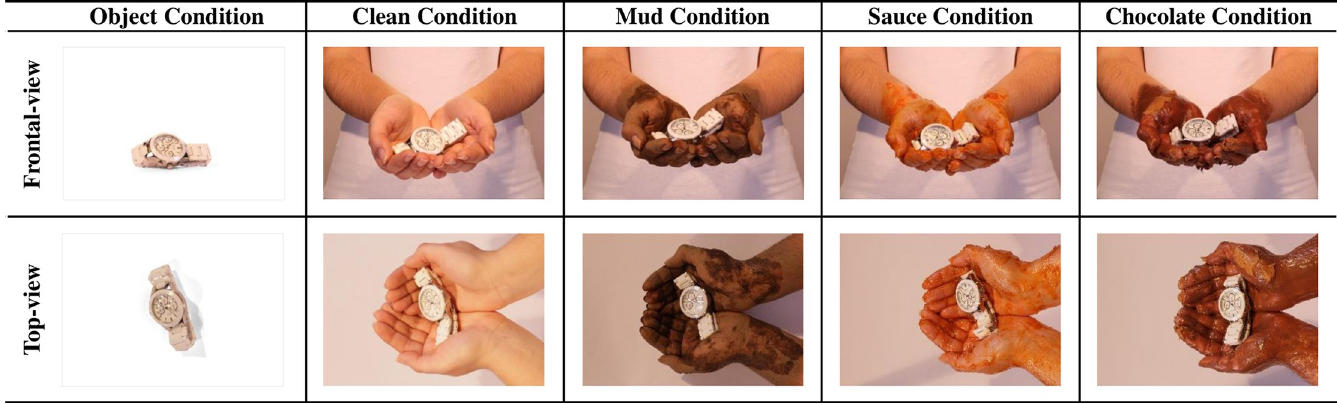
Fig 1. Examples of stimuli in each condition and camera